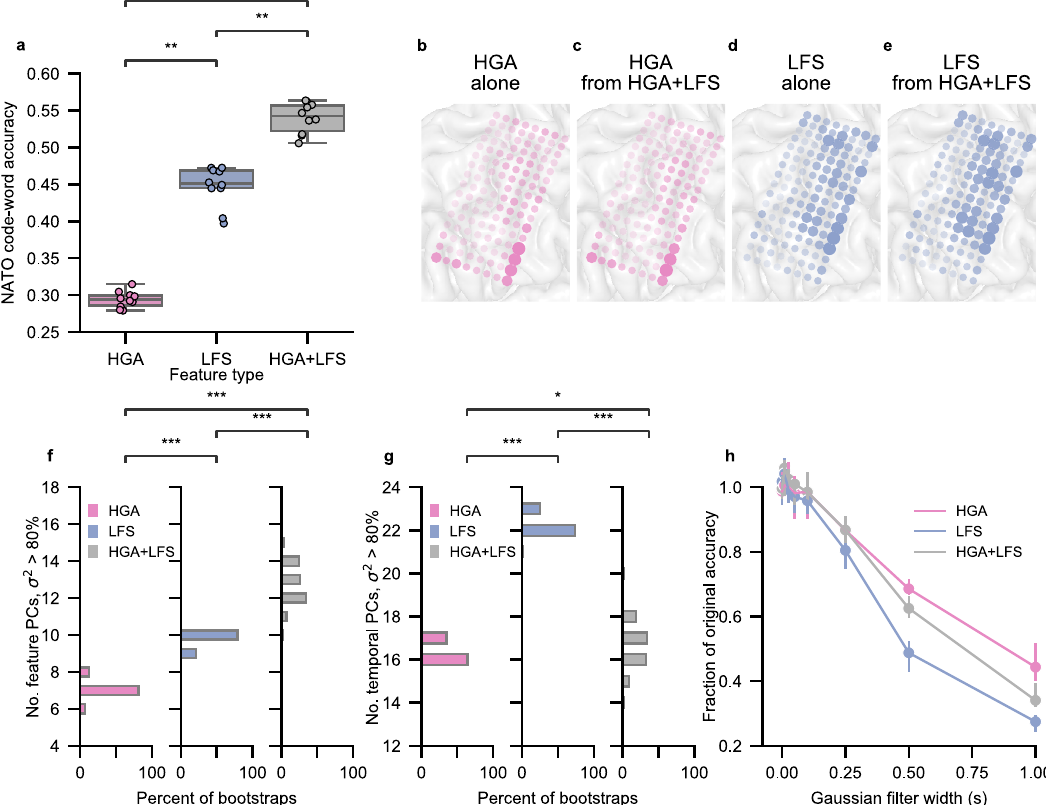
Fig. 3 | Characterization of high-gamma activity (HGA) and low-frequency signals (LFS) during silent-speech attempts. a 10-fold cross-validated classi fi ca- tion accuracy on silently attempted NATO code words when using HGA alone, LFS alone, and both HGA+LFS simultaneously. Classi fi cation accuracyusing only LFS is signi fi cantly higher than using only HGA, and using both HGA+LFS results in sig- ni fi cantly higher accuracy than either feature type alone (** P =4.71×10 − 4 , z =3.78 for each comparison, two-sided Wilcoxon Rank-Sum test with 3-way Holm-Bon- ferroni correction). Chance accuracy is 3.7%. Each boxplot corresponds to n = 10 cross-validation folds (which are also plotted as dots) and depicts the median as a center line, quartiles as bottom and top box edges, and the minimum and max- imum values aswhiskers (exceptfor data points thatare 1.5 times the interquartile range). b – e Electrode contributions. Electrodes that appear larger and more opa- que provide more important features to the classi fi cation model. b , c Show con- tributions associated with HGA features using a model trained on HGA alone ( b ) vs using the combined LFS+HGA feature set ( c ). d , e depict